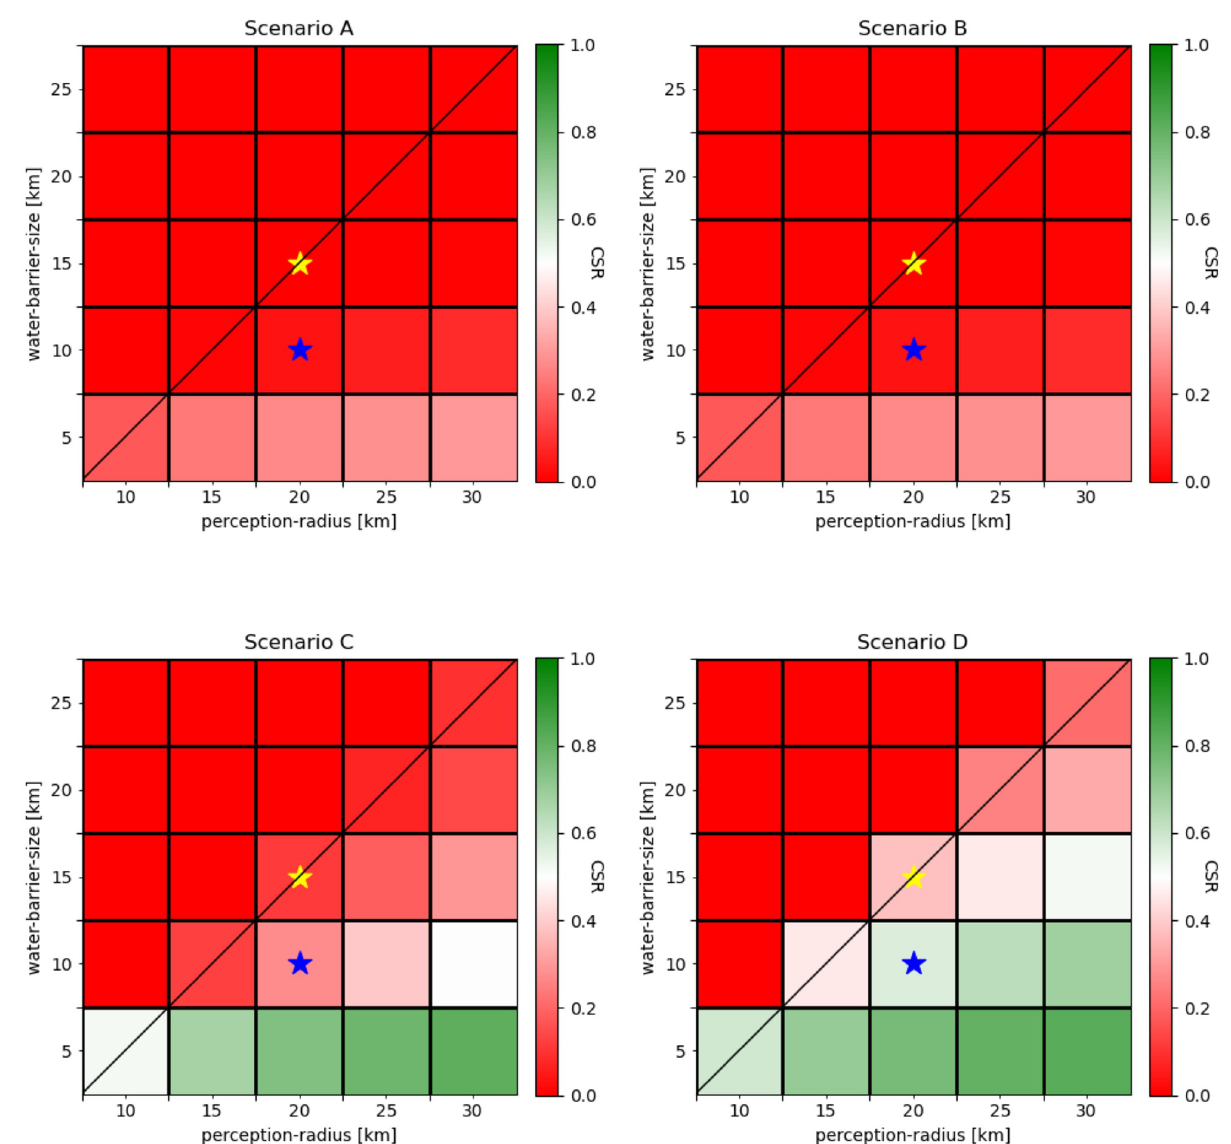
Fig 6. Two-factor sensitivity experiments for the radius of perception (perception-radius) and extent of the water barrier (water-barrier-size) for each scenario. The two-factor sensitivity experiments show the combined effect of the systematic and simultaneous variation of two factors on the average CSR response. The default response is shown by the blue asterisk and the median response is shown by the yellow asterisk. The position of the yellow asterisk in relation to the diagonal line displays the weight of the contribution of each of the two